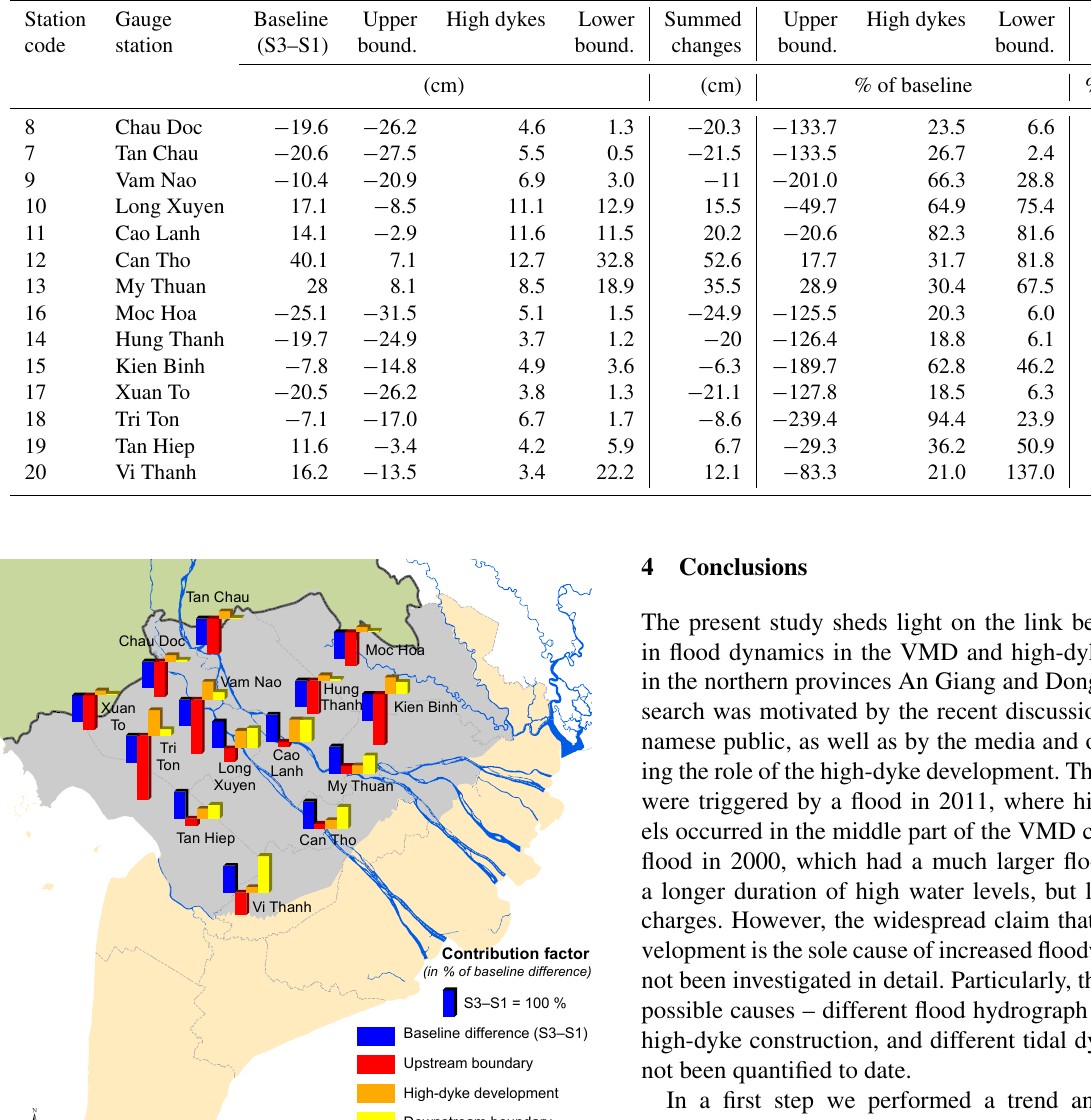
Table 6. Contribution of each factor to the alteration of water level between the floods 2000 and 2011 for key gauge stations in the VMD. The stations are listed from upstream to downstream and from small to large distance to the main rivers to remote. Station numbers refer to Fig. 1.